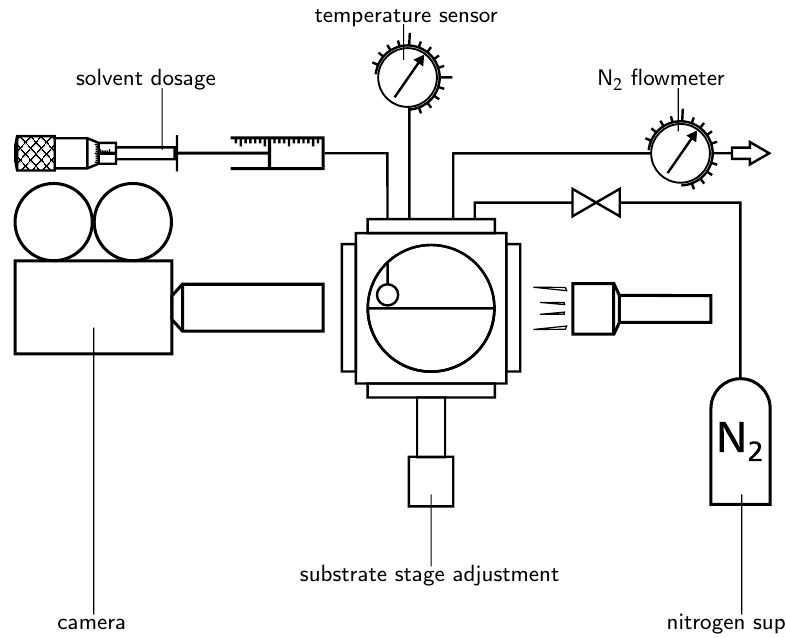
Figure 1. Sketch of the experimental set-up. Contact between solvent and substrate is initiated by increasing the volume of a solvent droplet until it touches the substrate. The distance between cannula and substrate (and thereby the initial drop diameter) can be varied by adjusting the vertical position of the substrate holder. Collimated light reaches the CMOS sensor of a high-speed camera through telecentric optics. Dry nitrogen is used to ensure a controlled atmosphere within the test